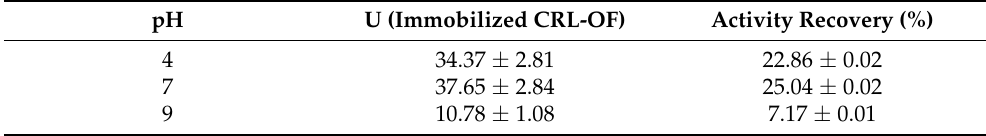
Table 1. Influence of buffer pH on the value of lipolytic activity (U) and activity recovery CRL-OF. pH U (Immobilized CRL-OF) Activity Recovery